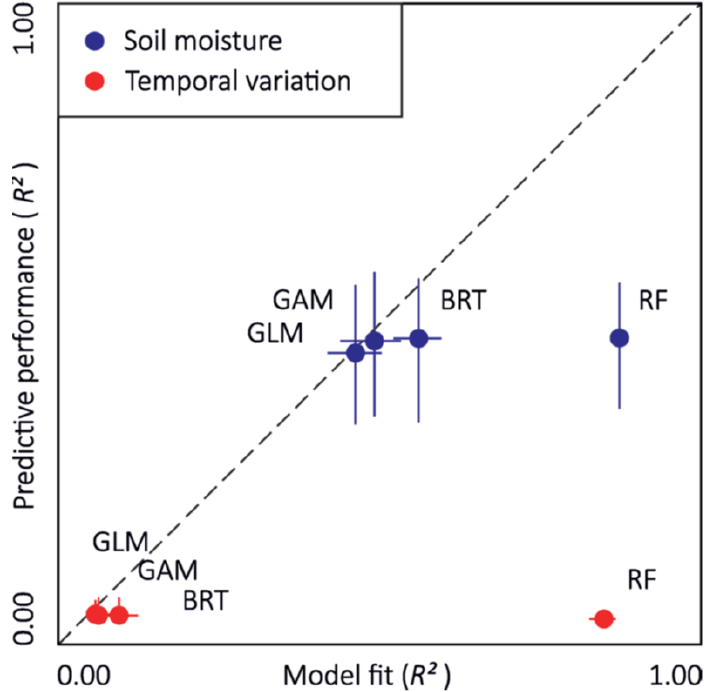
Figure 7. Comparing four soil moisture modelling methods. Reprinted with permission from Ref. [49] Copyright 2017,